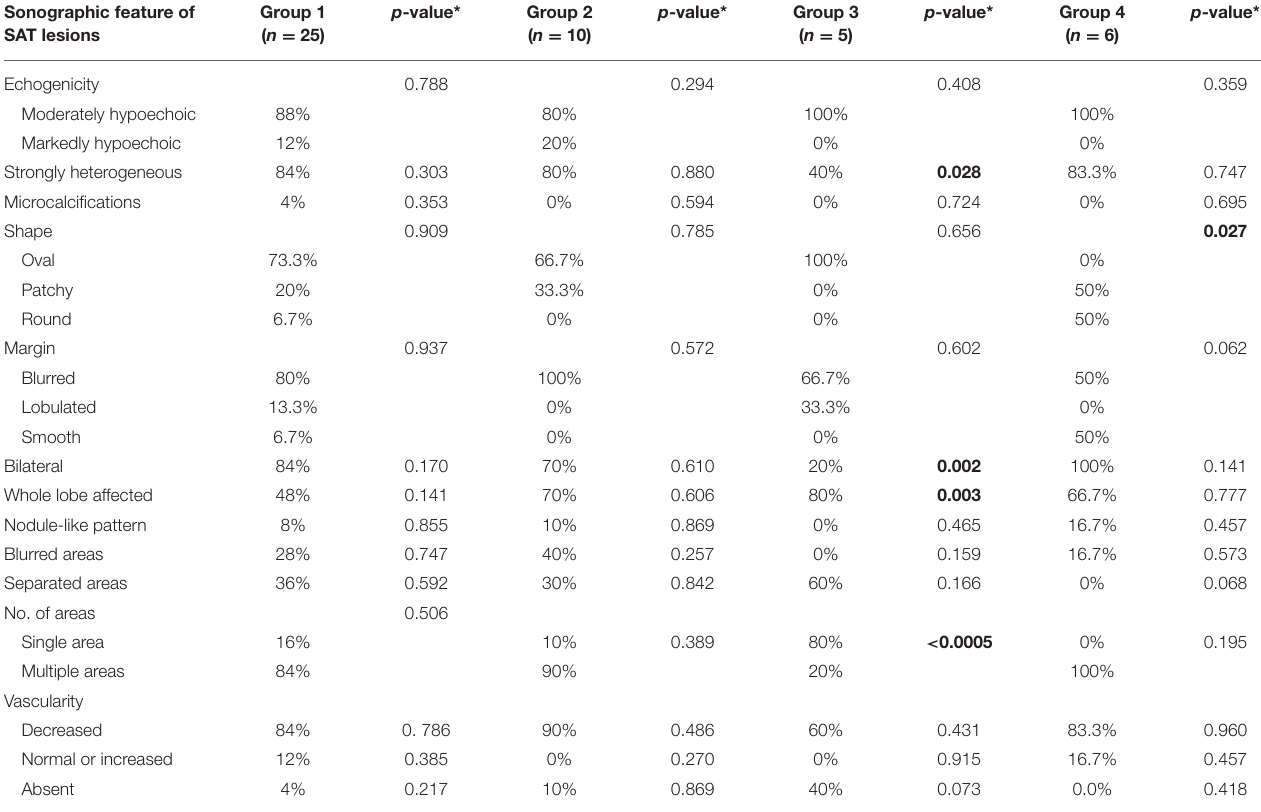
TABLE 1 | Sonographic characteristics of the SAT lesions in each group and comparison with all the other subjects. Sonographic feature of Group 1 SAT lesions ( n =